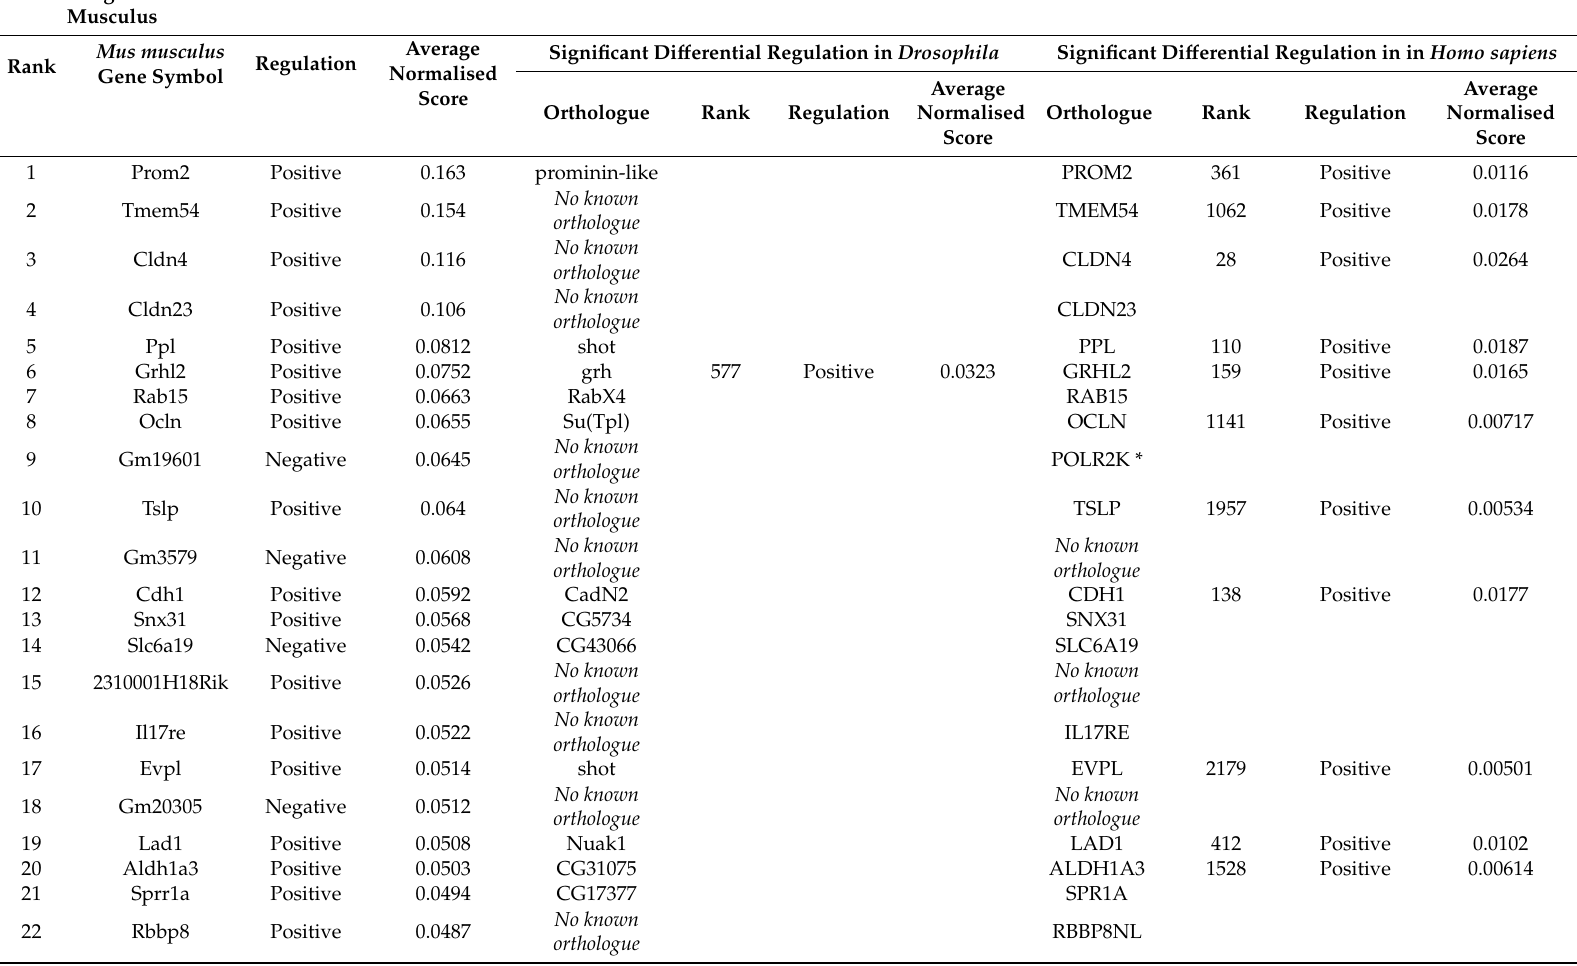
Table 4. Conservation of di ff erentially regulated genes between mouse, Drosophila and human across all biological contexts, following modulation of grh / Grhl function. Grhl Targets - Mus